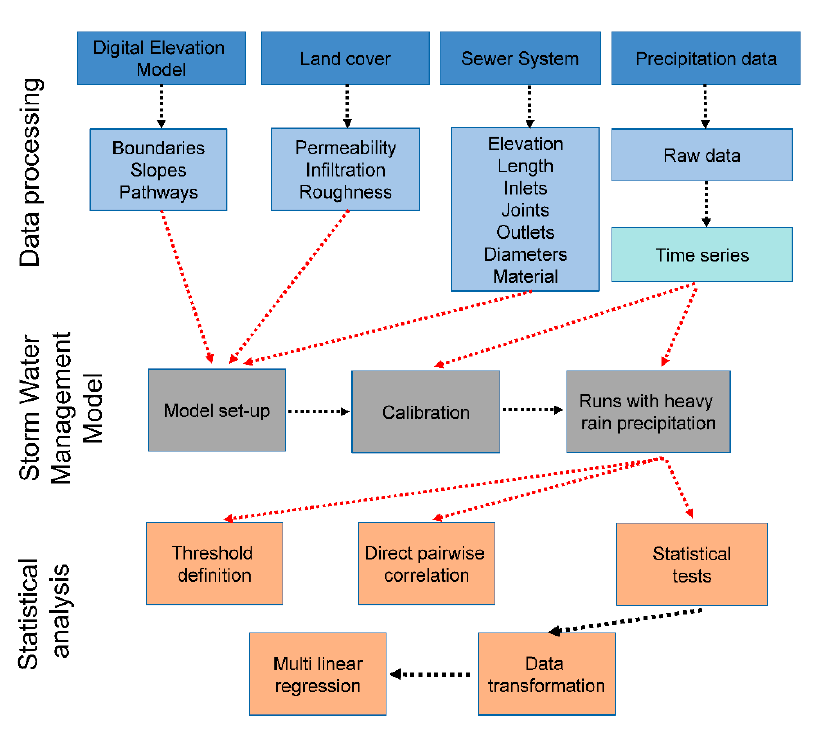
Figure 1. Developed workflow.